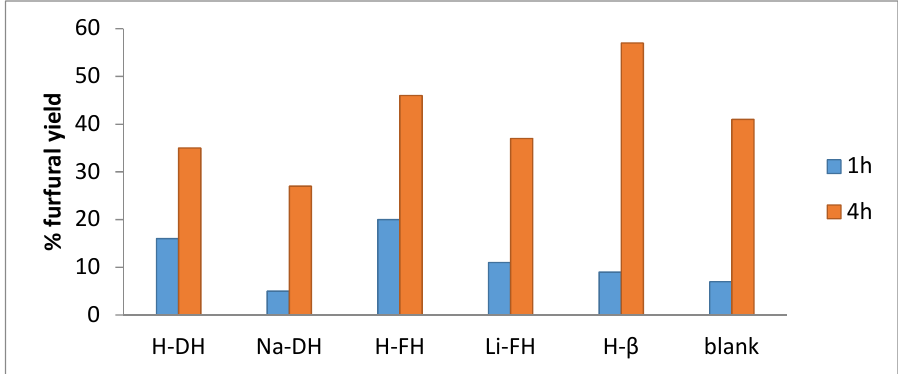
Figure 7. Furfural yields (%) using aqueous commercial xylose solutions (36 g/L) with toluene as co-solvent in a ratio of 1:1 at 160 °C for 1 and 4 h for all catalysts. Catalysts 2019 , 9 , x FOR PEER REVIEW